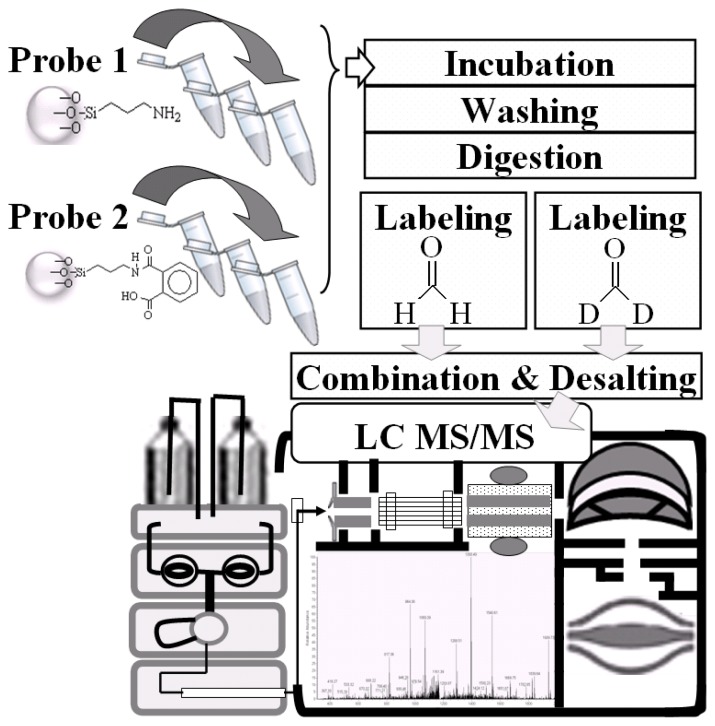
Flow chart and sample pretreatment for quantitative approaches in proteome analyses coupled with nano-liquid chromatography (LC)-mass spectrometry (MS)/MS for protein identification and quantification.